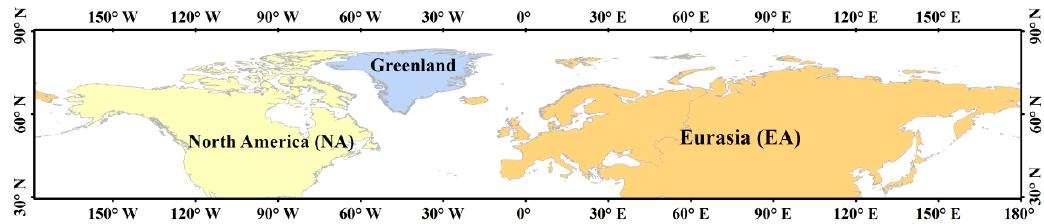
Figure 1. Overview of the study area. NH includes Eurasia (EA) continent, North America (NA) continent, and Greenland.